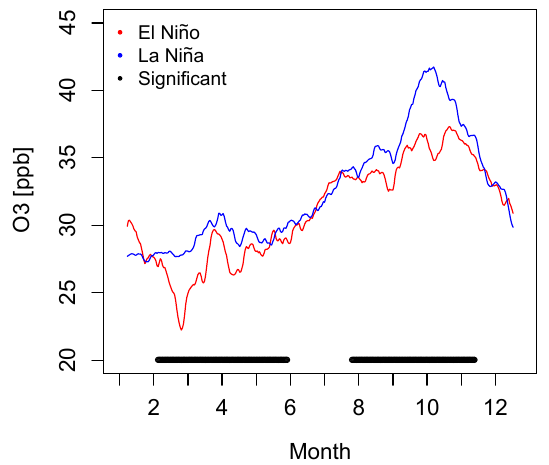
Figure 10. Computed annual cycle of O 3 mole fractions at TLL in daily resolution during El Niño days (NINO3.4 Index > 0.5, total 1914 days between December 1995 and December 2015) and La Niña days (NINO3.4 Index < − 0.5, total 2330 days between De- cember 1995 and December 2015). Black lines show significant differences between the two curves. NINO3.4 data are derived from daily index reconstructions from SST OI v2 1 / 4 ◦ data by